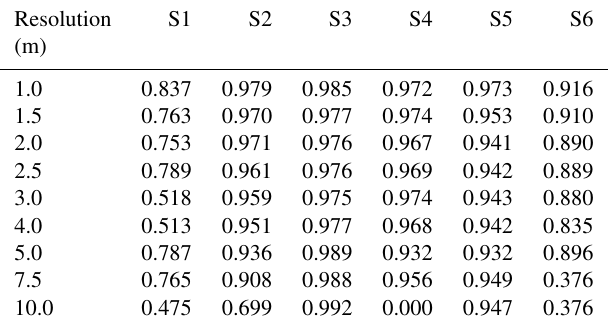
Table A2. Table of precision for sites S1 to S6 (columns) with no Wiener filter, for resolutions varying between 1 and 10m (rows).